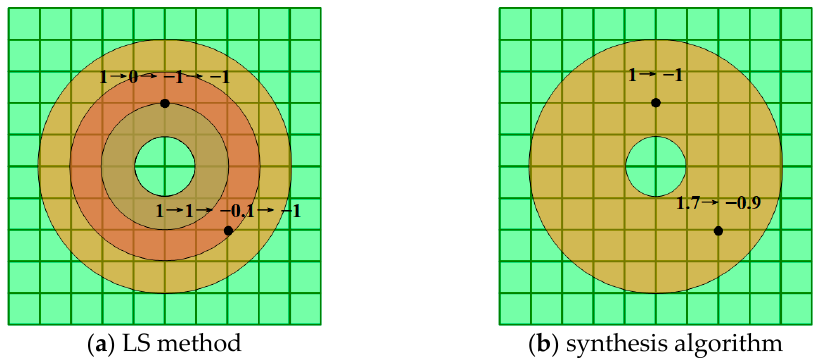
Figure 7. Iteration process diagrams: ( a ) LS method; and ( b ) synthesis algorithm.